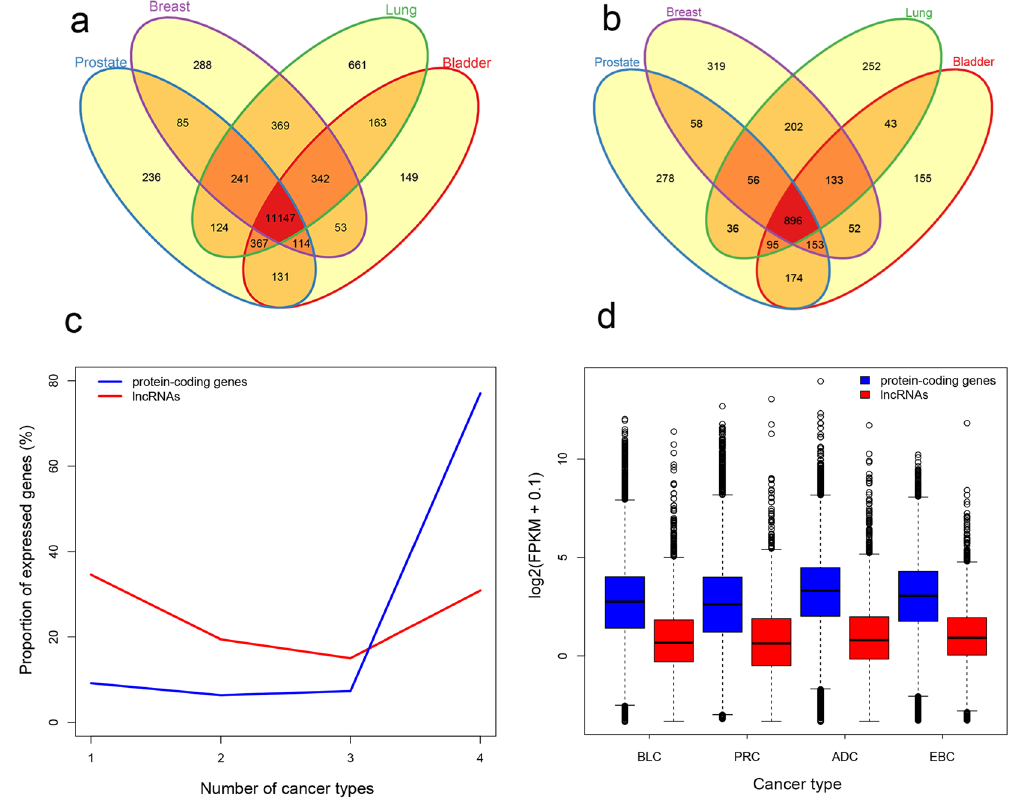
Figure 1. Distributions and expression levels of expressed genes in the four cancer types. The venn plot of 14,470 expressed protein-coding genes ( a ) and 2,902 expressed lncRNA genes ( b ). ( c ) The proportion of expressed protein-coding genes (blue) and lncRNA genes (red) appearing in different number of cancers. The x axis depicts the number of cancer types. The y-axis depicts the proportion of expressed genes, which is the ratio between the counts of expressed genes appearing in different number of cancers and the total counts of all expressed genes. ( d ) The expression levels (log2(FPKM + 0.1)) of expressed protein-coding genes (blue) and lncRNAs (red) in each cancer